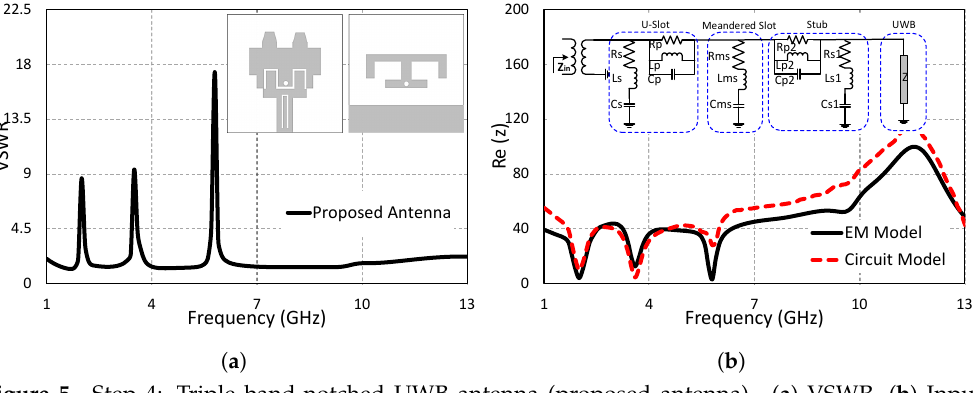
Figure 5. Step 4: Triple band-notched UWB antenna (proposed antenna). ( a ) VSWR. ( b ) Input impedance